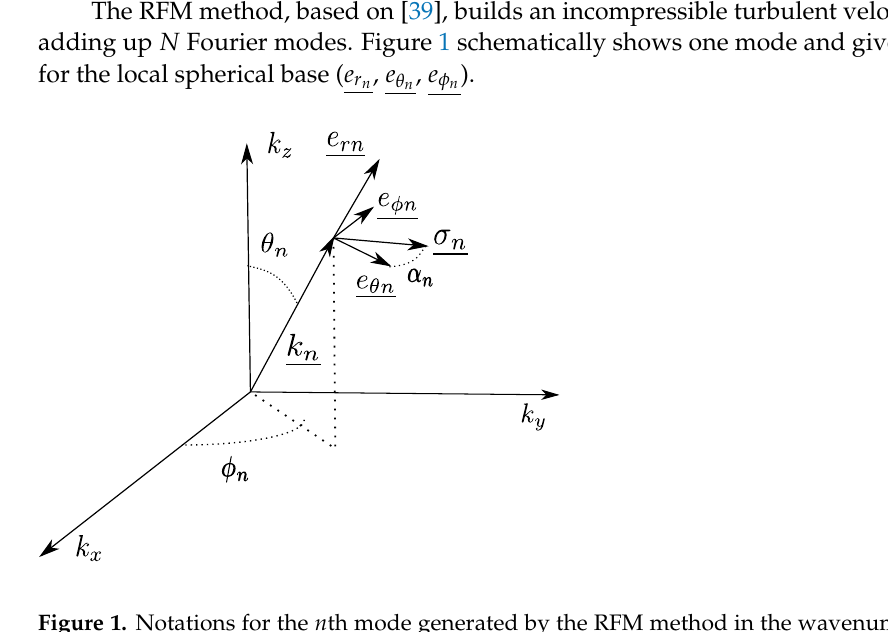
Figure 1. Notations for the n th mode generated by the RFM method in the wavenumber domain. Figure inspired by